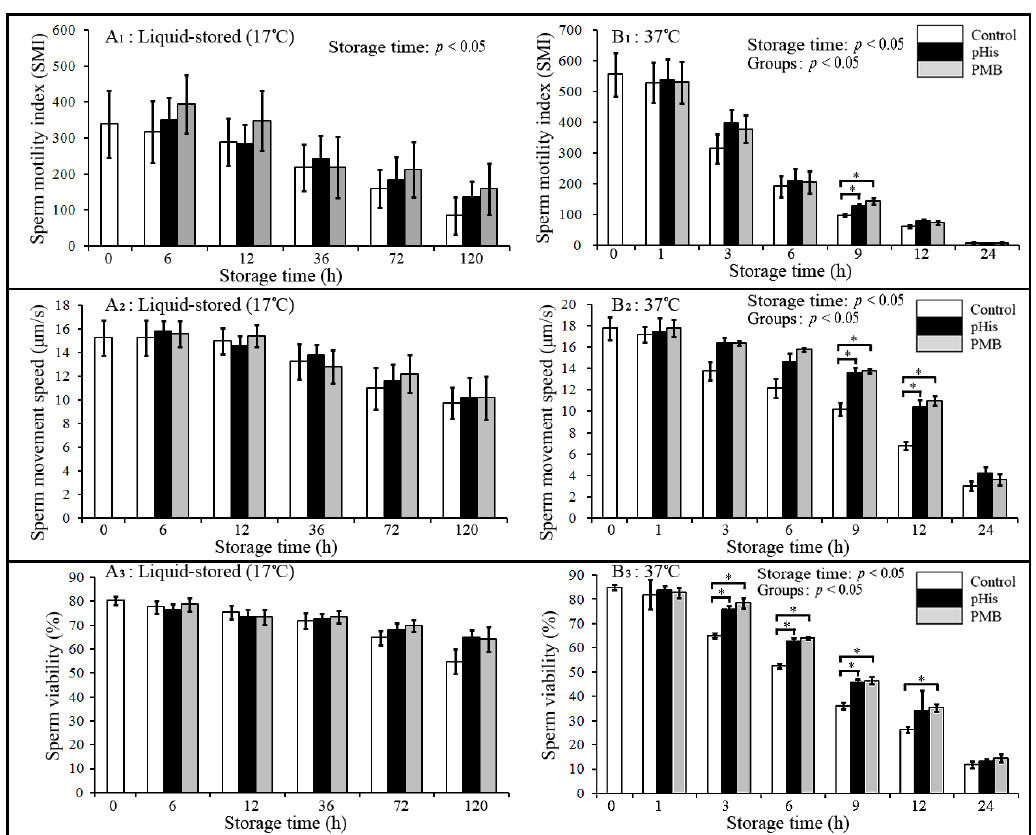
Figure 2. Changes in the sperm motility index, movement speed, and viability during liquid storage and at 37 °C incubation. * indicates a significant difference between the groups ( p < 0.05). Panels A 1 , A 2 , and A 3 depict the changes in sperm motility, movement speed, and viability, respectively, in liquid-stored (17 °C) boar semen; whereas panels B 1 , B 2 , and B 3 depict changes in sperm motility, movement speed, and viability, respectively, in boar semen incubated at 37 °C. Boar sperm were diluted with BTS extender in the control group, and 100 μg /mL PMB or pHis was added to the BTS extender in PMB or pHis-treated groups. The changes in the sperm motility, movement, and viability were correlated with storage time extension in 37 °C incubation groups.